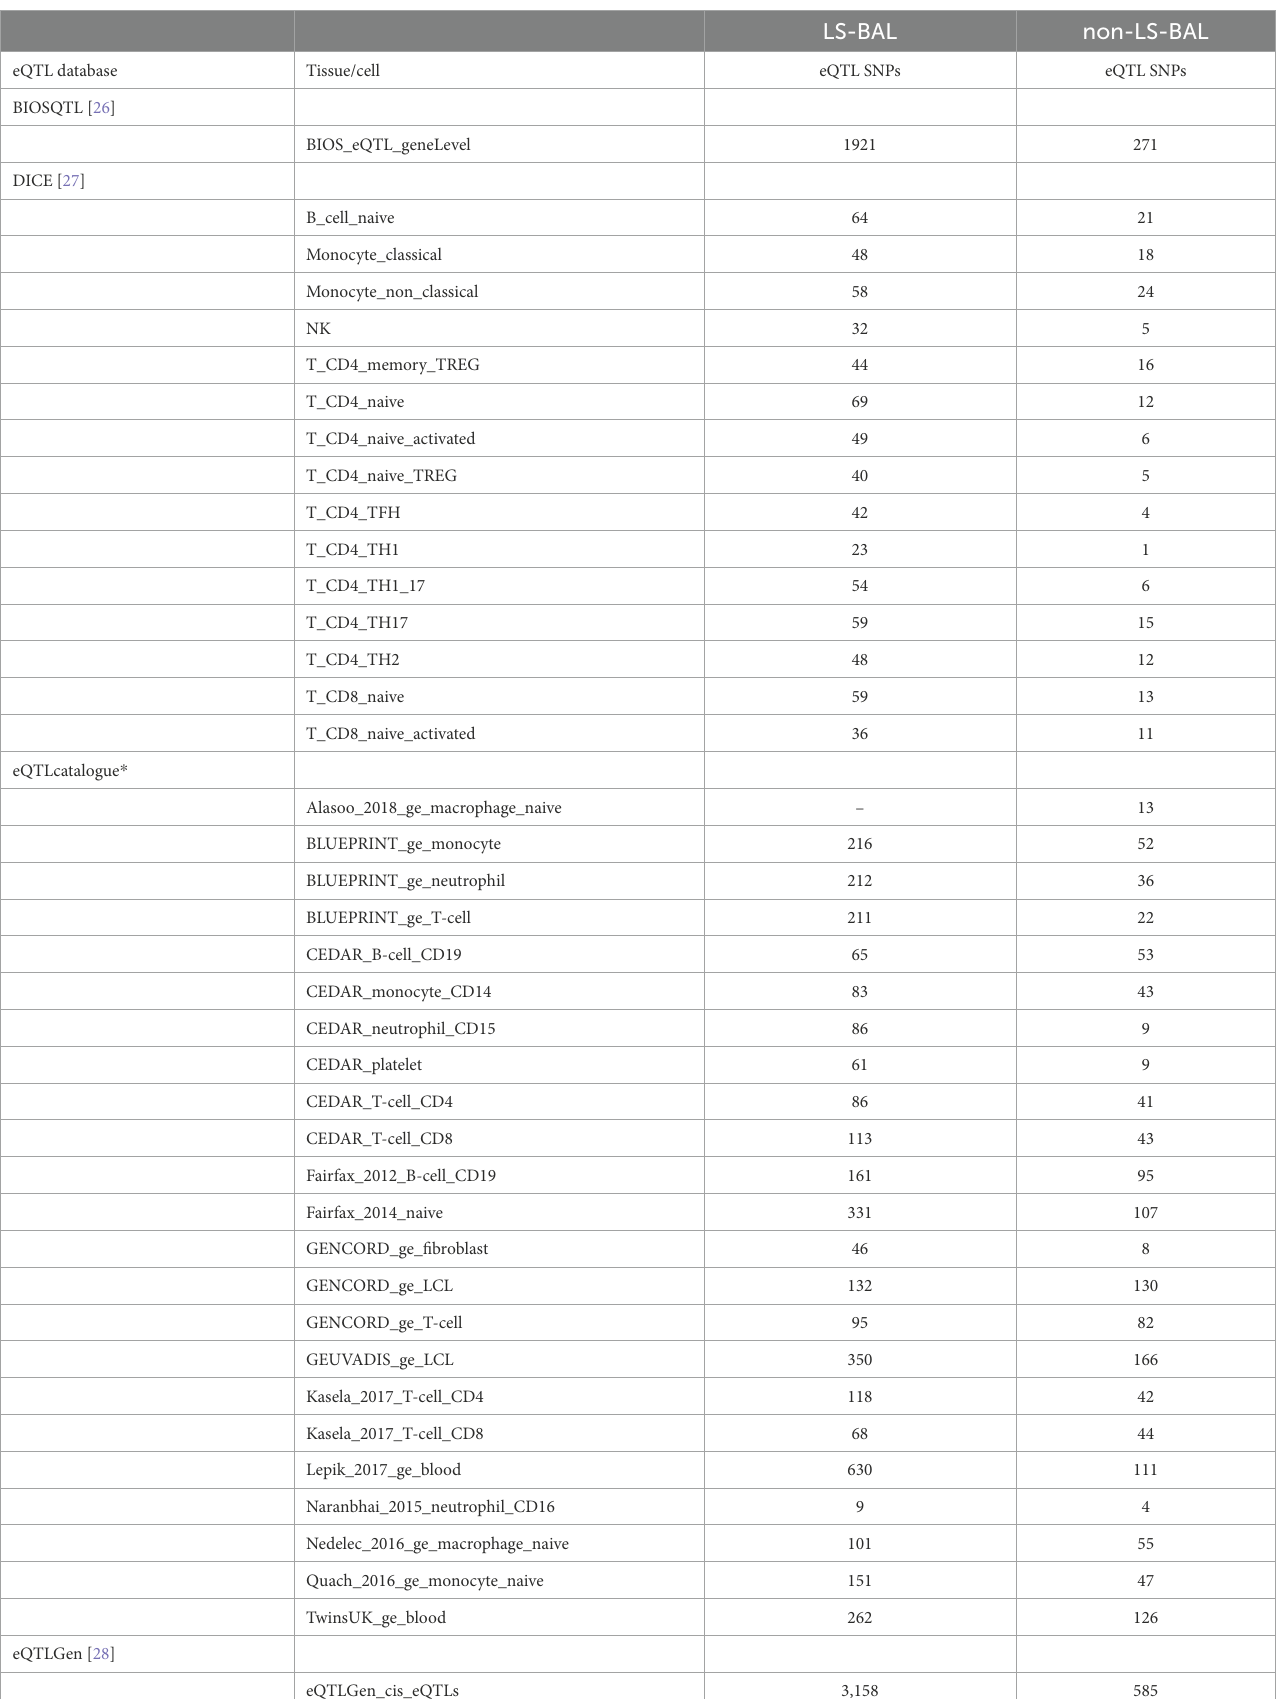
LS-BAL non-LS-BAL